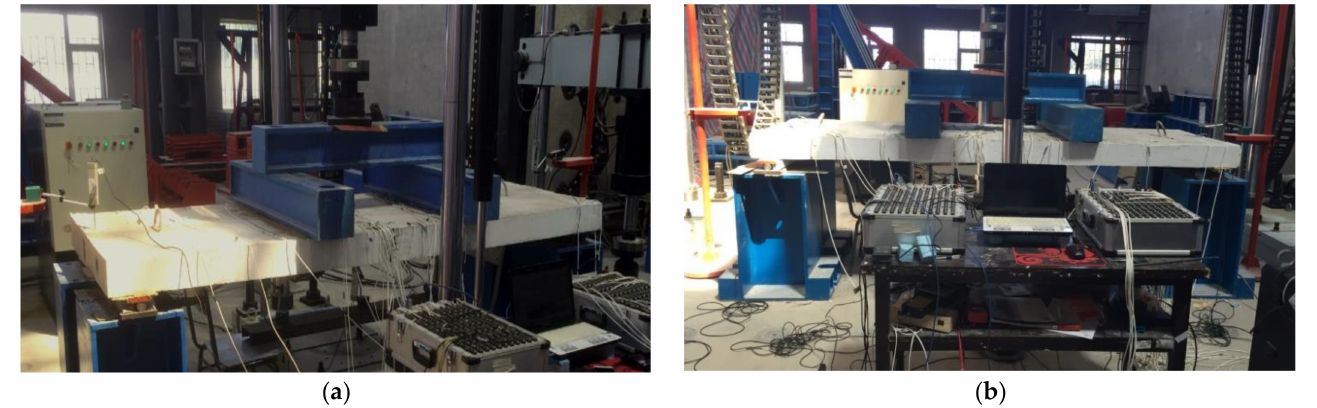
Figure 2. Test arrangements. ( a ) TestB-1; ( b )